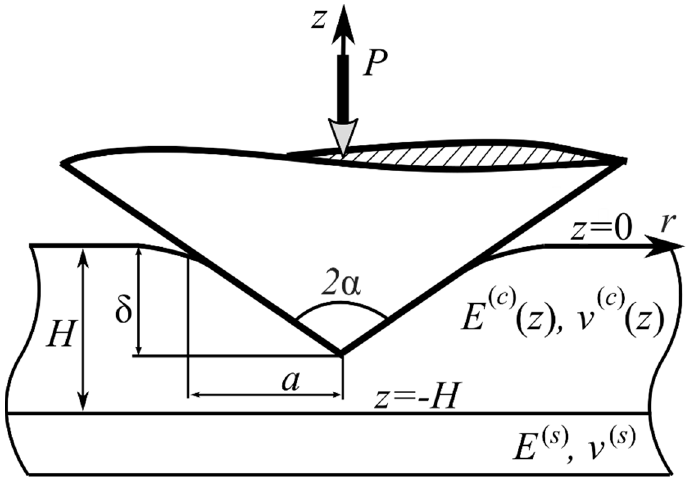
Figure 1. The scheme of the contact problem.